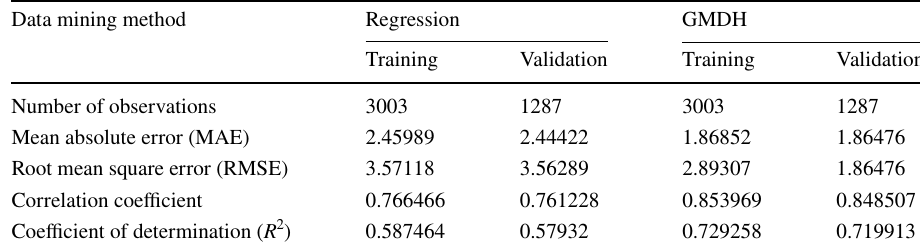
Table 9 Summary of the two prediction models